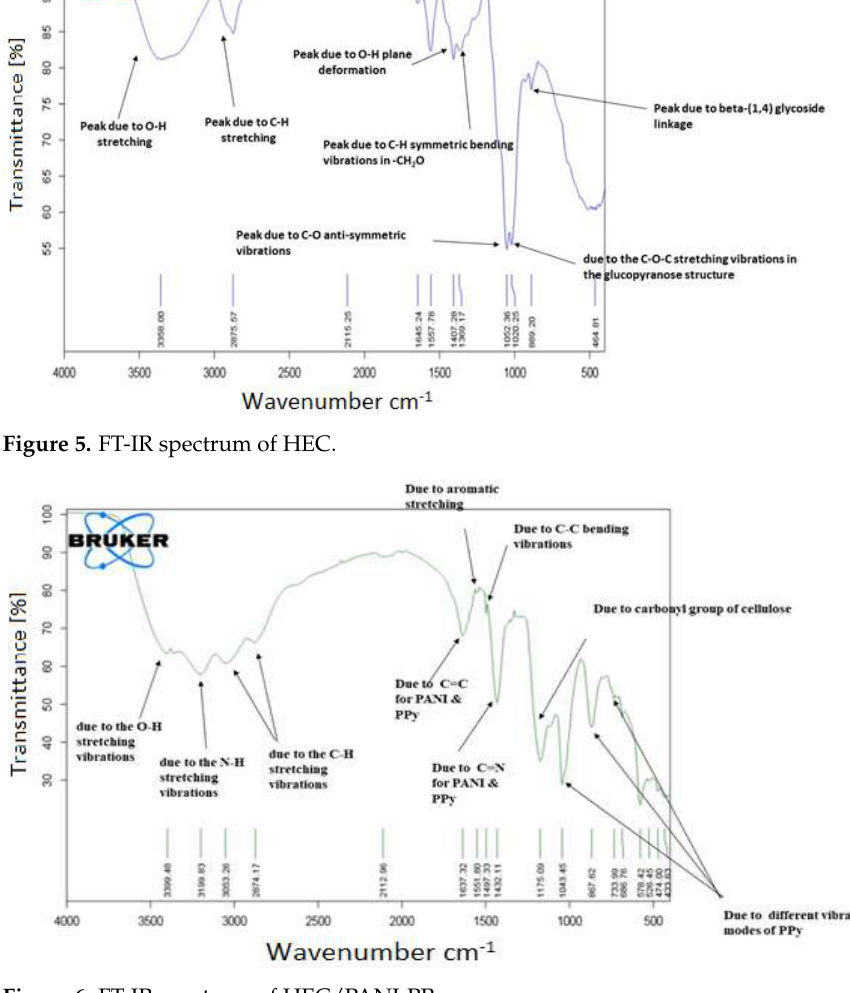
Figure 6. FT-IR spectrum of HEC/PANI-PPy.